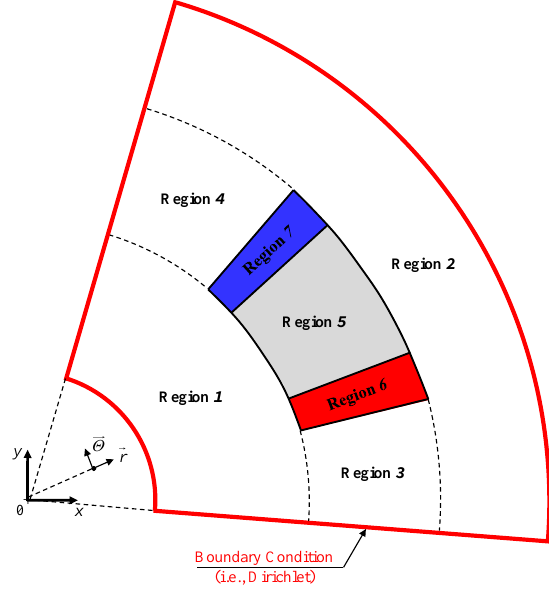
Figure 2. Definition of regions in the air- or iron-cored